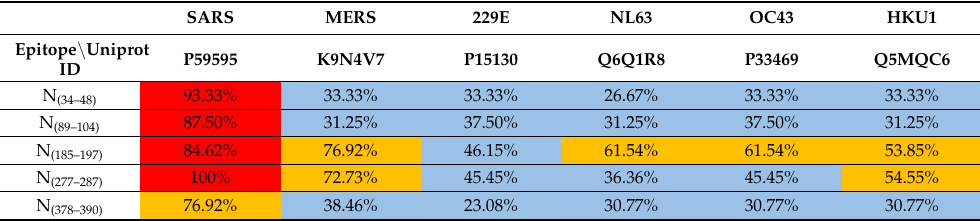
Table 3. SARS-CoV-2 N-protein epitopes conservancy analysis among human coronaviruses. SARS MERS 229E NL63 OC43 HKU1 Epitope \ Uniprot ID